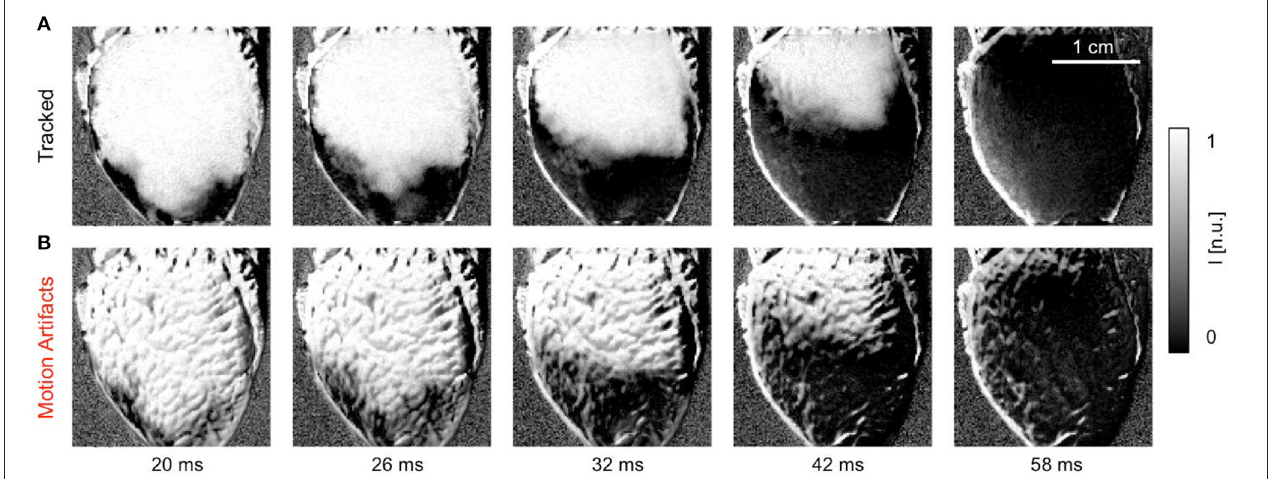
FIGURE 5 | Efficacy of motion tracking and motion artifact compensation during electromechanical optical mapping: planar action potential wave propagating upwards across ventricular surface of a rabbit heart as the heart contracts (dark areas correspond to depolarized tissue and bright areas correspond to undepolarized tissue, staining Di-4-ANEPPS, pixel-wise sliding-window normalization [n.u.]). See also Supplementary Video 2 . (A) Motion-stabilized image sequence with substantial reduction in dissociation-related motion artifacts after motion tracking and numerical motion-stabilization. (B) The same image sequence without motion tracking and stabilization. Motion artifacts appear as a high-frequency, network-like spatial pattern with black-and-white deflections superimposing and distorting the action potential wave pattern. Both image series were processed in the same way before and after motion tracking.